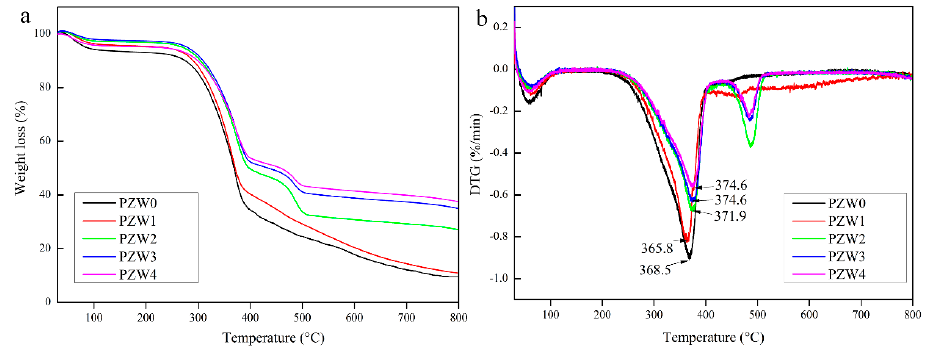
Figure 5. The TG ( a ) and DTG ( b ) curves of PZW0, PZW1, PZW2, PZW3 and PZW4.